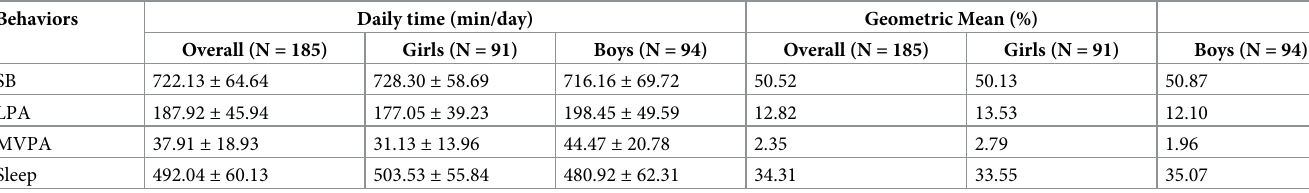
Table 2. Descriptive and compositional statistics of daily use of time in each human behavior. Behaviors Daily time